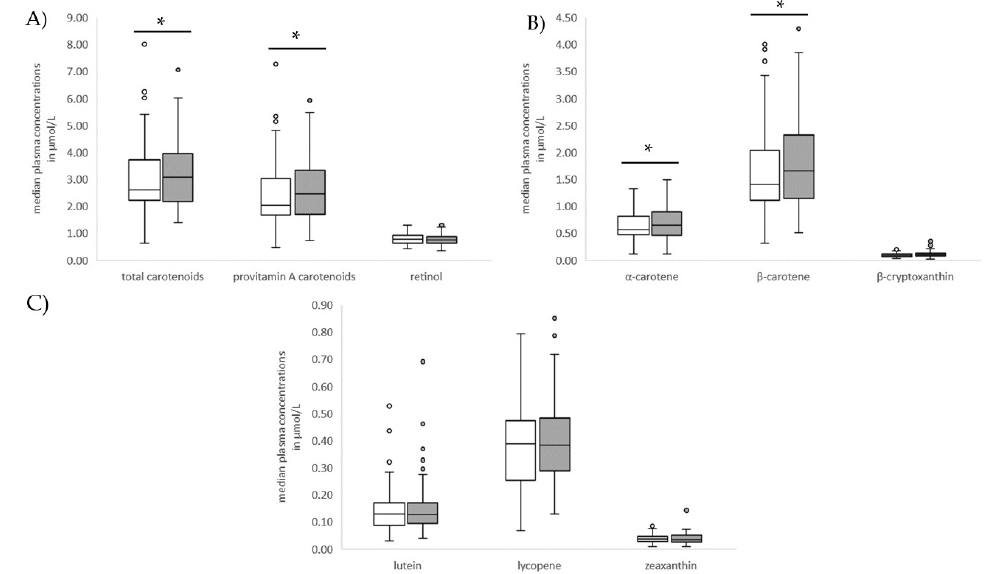
Figure 2. Median plasma: ( A ) total carotenoid, provitamin A carotenoid, and retinol; ( B ) provitamin A carotenoid ( α -carotene, β -carotene, and β -cryptoxanthin); ( C ) non-provitamin A carotenoid (lutein, lycopene, and zeaxanthin) concentrations across the genotypes in single nucleotide polymorphism (SNP) rs6564851.TT (white box, n = 89); GT / GG (grey box, n = 100). Data presented as medians